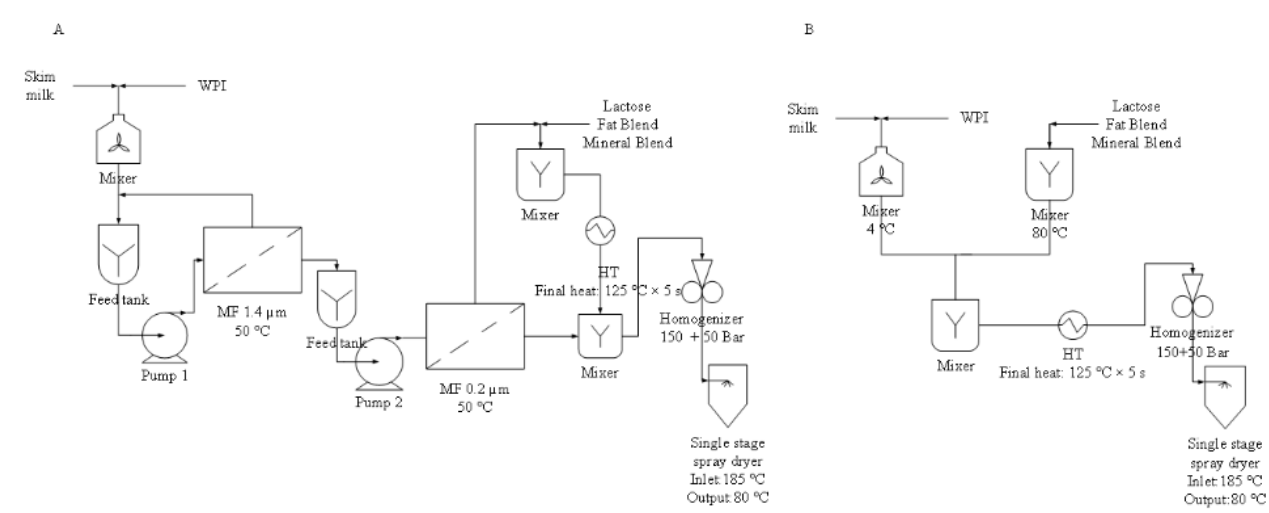
Figure 1. Processing scheme for the production of ( A ) membrane-filtrated infant milk formula (MEM-IMF) and ( B ) high- heat-treated infant formula (HT-IMF).